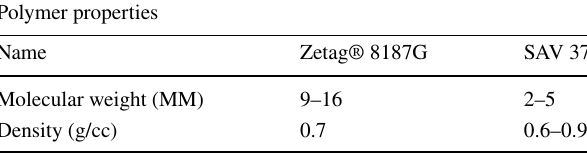
Fig. 2 Rheometer for measuring viscosity of